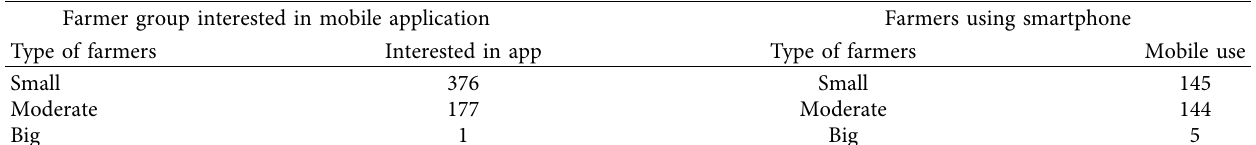
Table 4: Type of farmers interested in mobile apps and smartphones.